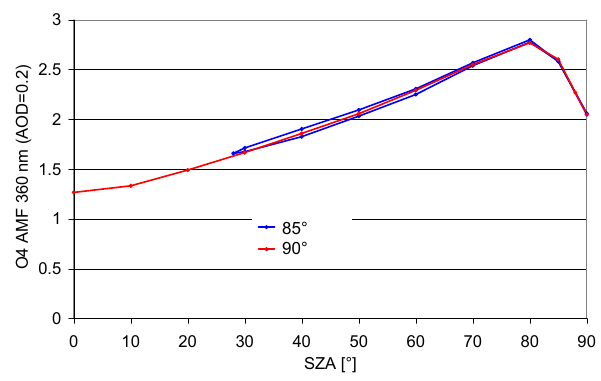
Figure 16. Comparison of the clear-sky reference values of the O 4 AMF for elevation angles of 85 and 90 ◦